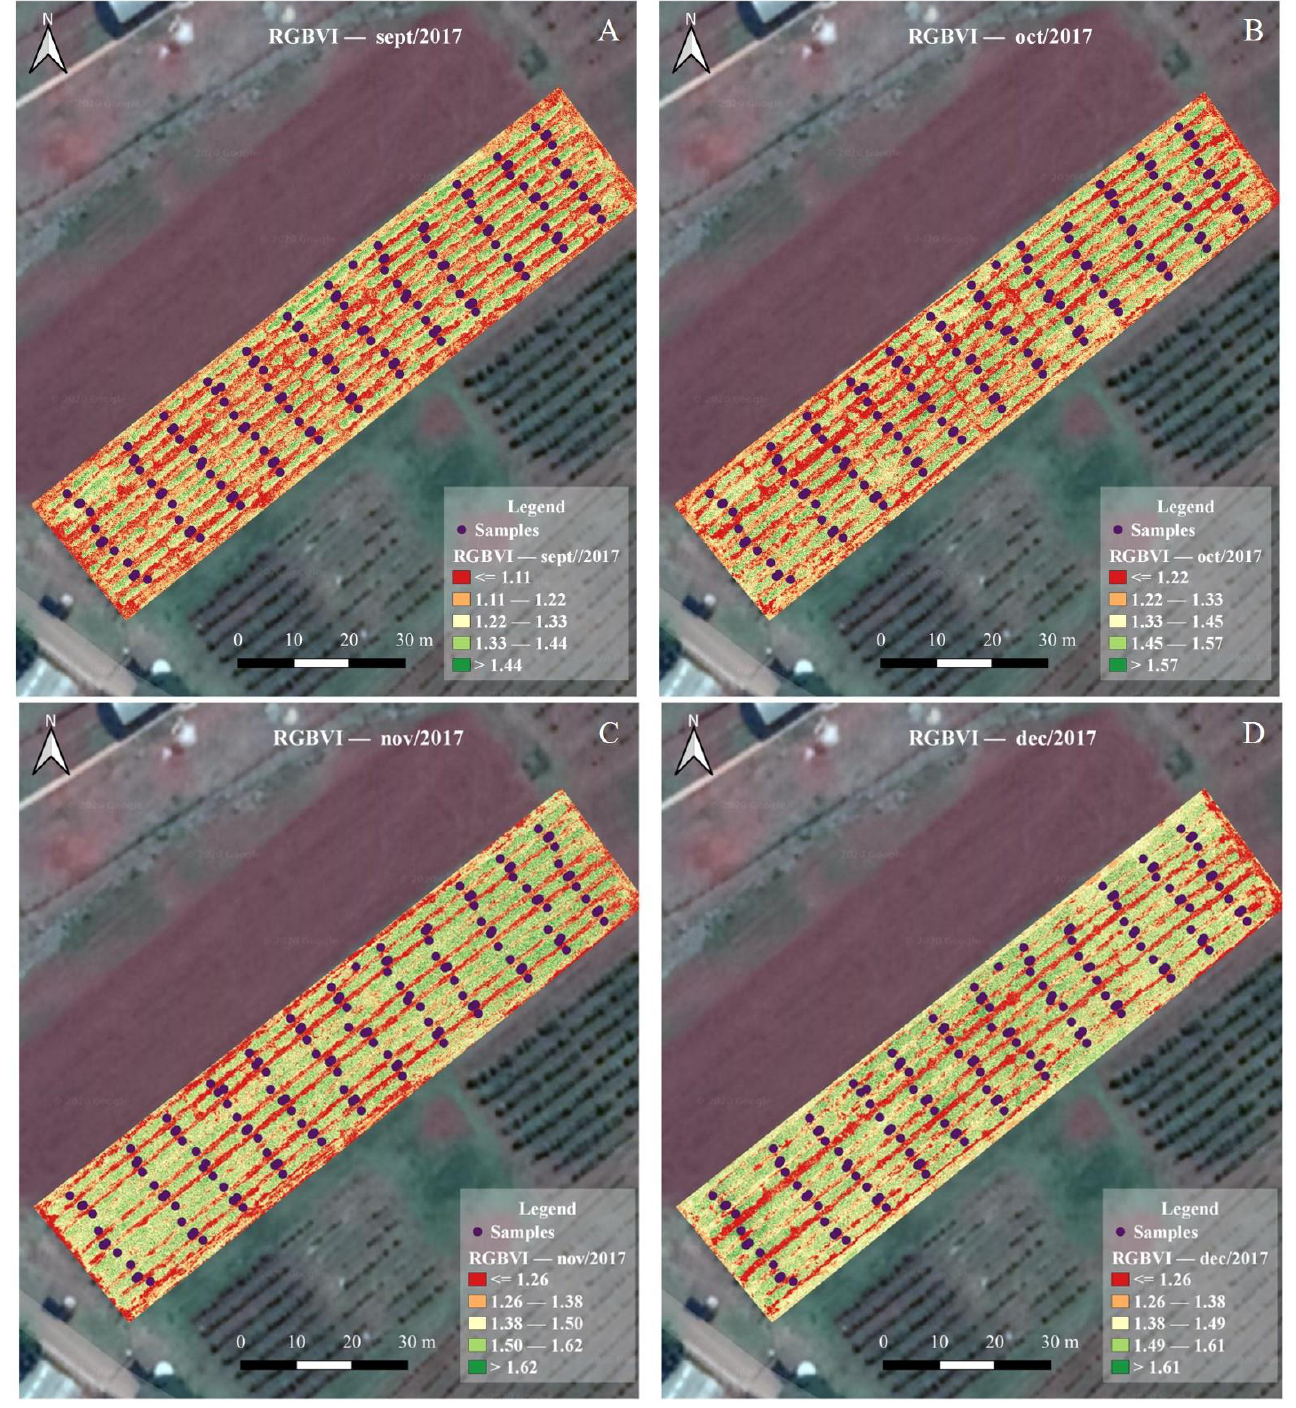
Figure 8. Third phase of the vegetative cycle of coffee evidenced by RGBVI: ( A ) —RGBVI/september, ( B )—RGBVI/october, ( C )—RGBVI/november, ( D )—RGBVI/december.